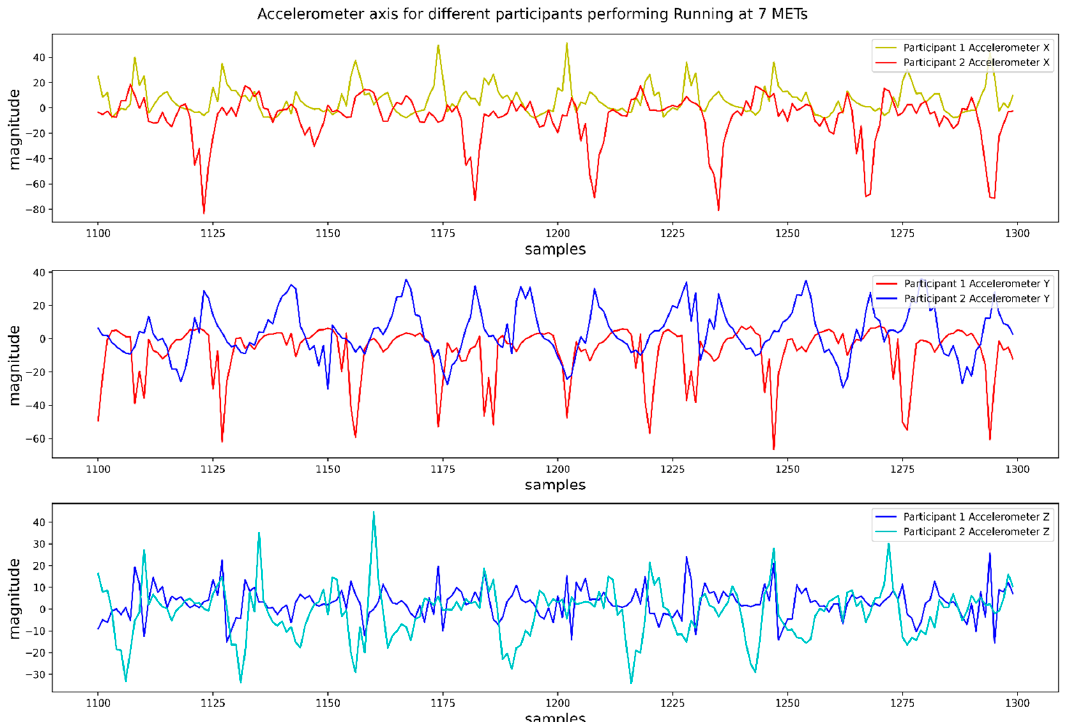
Figure 3. Values of three accelerometer axes for the same activity performed by two different participants.